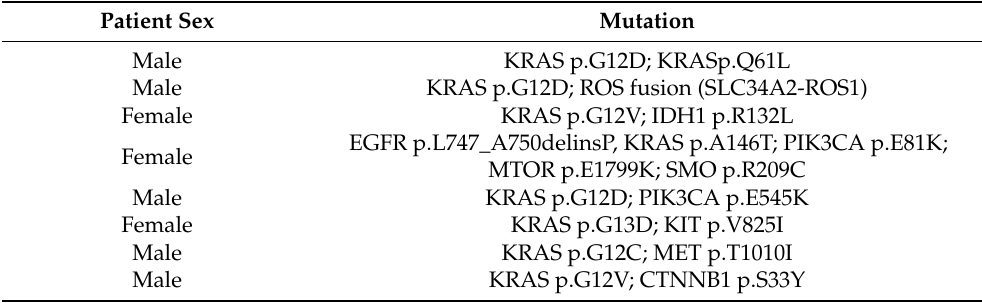
Table 1. List of KRAS concomitant mutations identified.